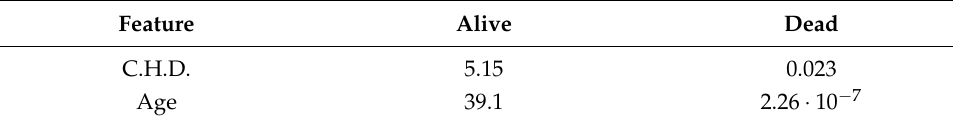
Table 9. Hypothesis testing results for the outcome